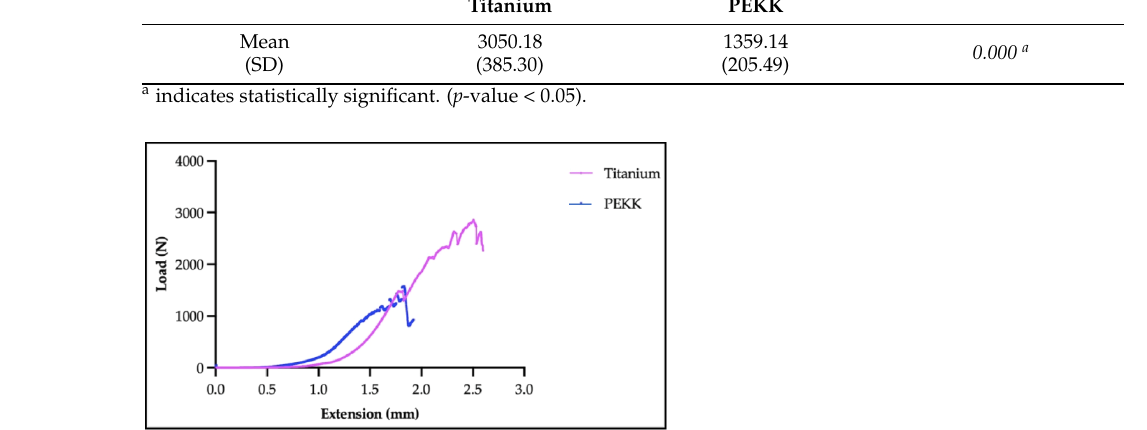
Figure 5. Load-extension graphs of experimentally veneered FPDs fabricated with PEKK and tita- nium